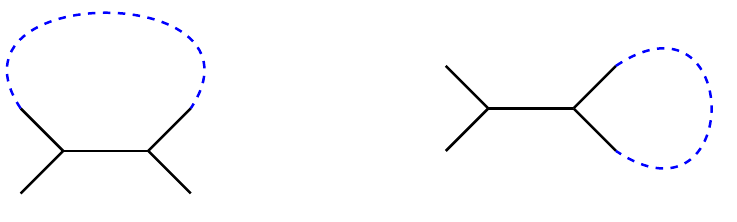
Figure 1 . Two-point conformal blocks in the s -channel (right) and t -channel (left). The s -channel loop consists of two segments with di(cid:11)erent conformal